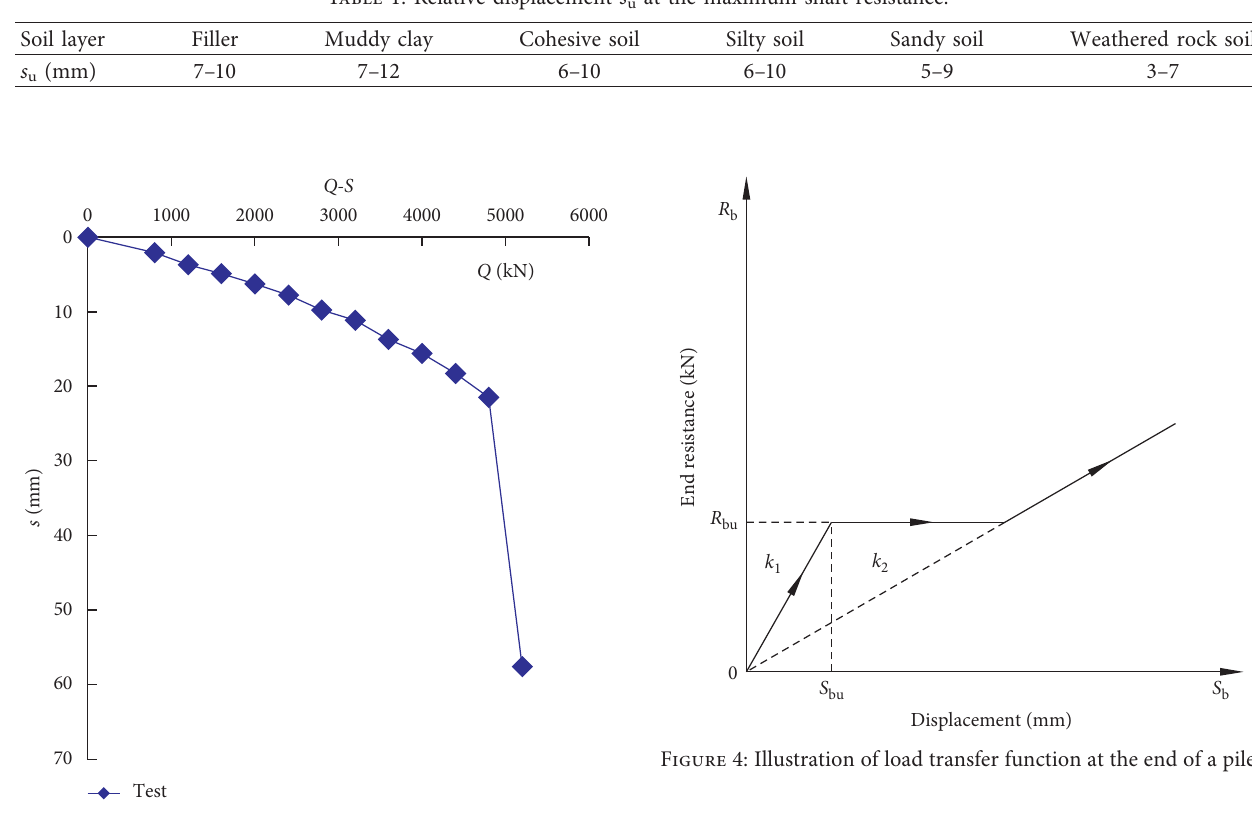
Figure 2: Illustration of the load transfer function at the pile side. Table 1: Relative displacement s u at the maximum shaft resistance.